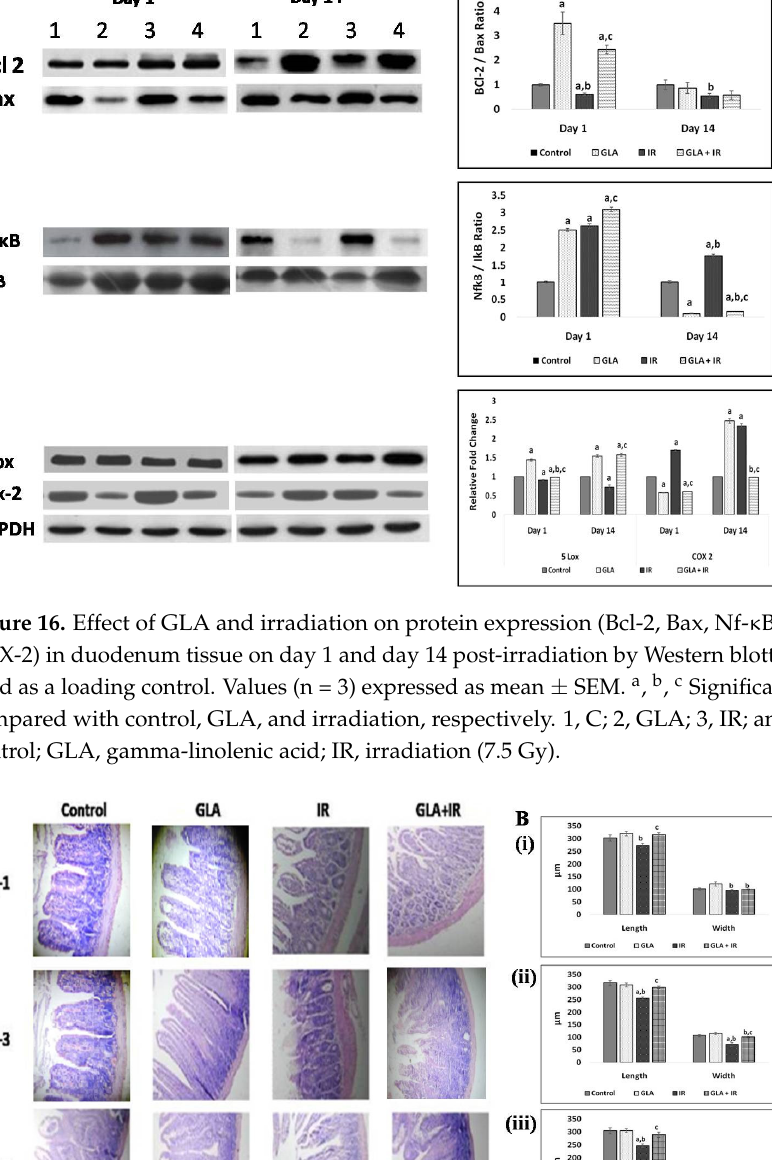
the small intestine (Figure 17).